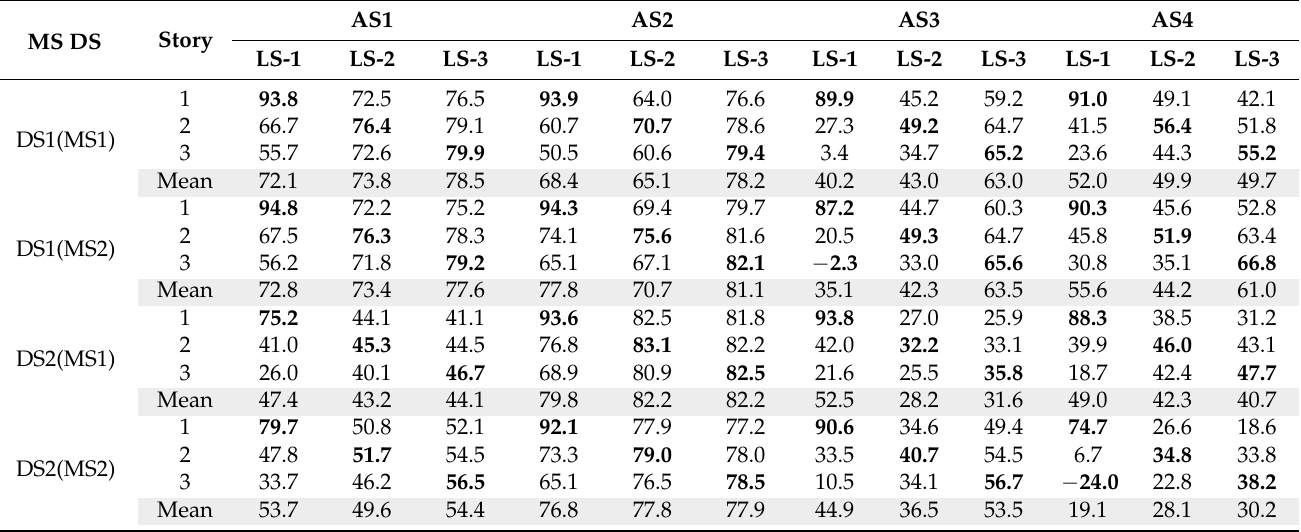
Table 7. Peak displacement degradation percentage (PDDP) (%) of MD-RC frames under different retrofitting schemes. MS DS